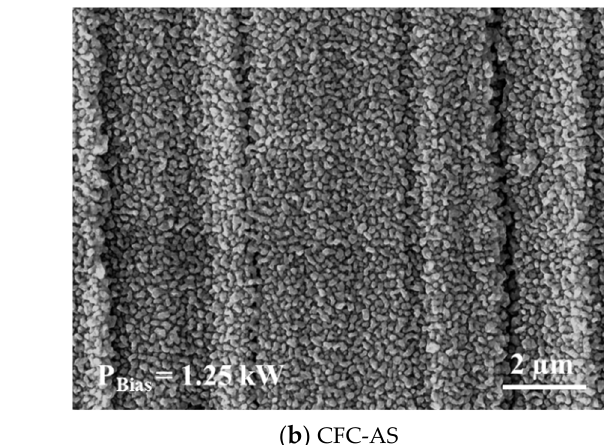
Figure 11. GDOES concentration depth profiles of nitrogen and carbon (in at.%) after ASPNC treatment at different bias conditions for a steel AS ( Φ CH4 = 4 slh) ( a ) and a CFC-AS ( b ) at H 2 :N 2 = 1:1, p = 3 mbar, T = 460 °C, Φ Total = 80 slh, and t = 5 h.